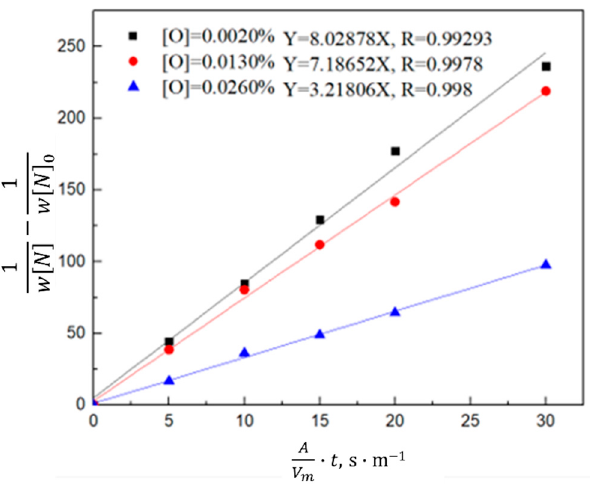
Figure 18. Kinetics of nitrogen removal from the molten steel with different oxygen contents.